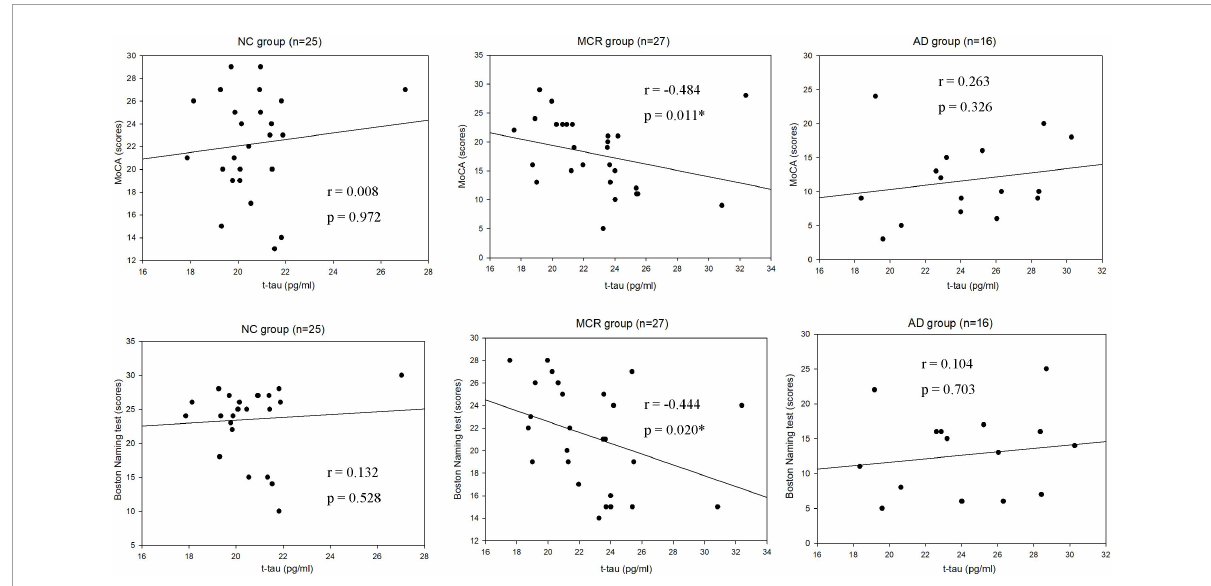
FIGURE3 Scatterplots of the associations between Montreal Cognitive Assessment (MoCA) scores, Boston Naming test scores, and plasma t-tau levels (pg/ml) in the three group. NC, normal cognition; MCR, Motoric Cognitive Risk syndrome; AD, Alzheimer’s disease; t-tau, total tau; MoCA, Montreal Cognitive Assessment; * p <